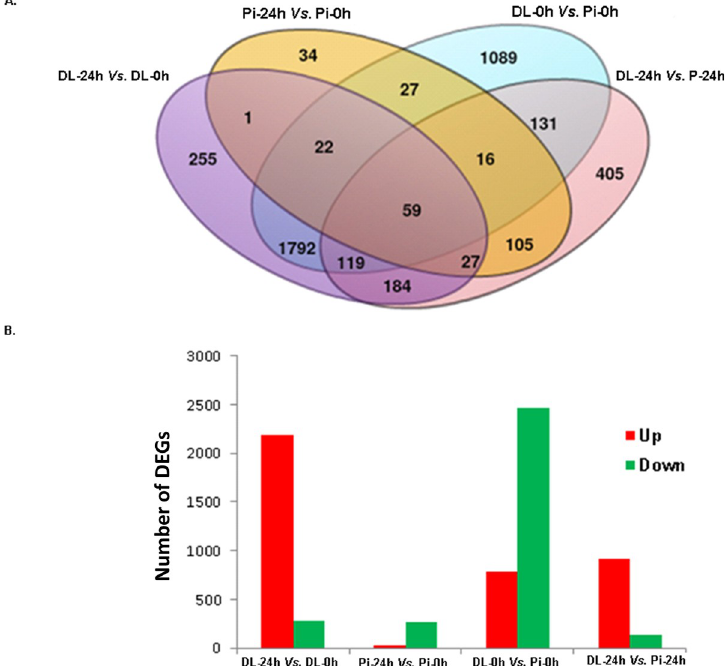
Fig 2. Number of DEGs after PRRSV vaccination. (A) The intersecting venn diagram demonstrates the number of DEGs identified at four contrast pairs such as PBMCs of DL pigs between pre and 24 h post vaccination (DL-24h vs. DL-0h); PBMCs of PI pigs between pre and 24 h post vaccination (Pi-24h vs. Pi-0h); unvaccinated PBMCs between DL and Pi pigs (DL-0h vs. Pi-0h), and vaccinated PBMCs between DL and Pi pigs (DL-24h vs. Pi-24h). (B) The bar graphs depict the proportion of DEGs showed their expression either up regulated (red bars) or down regulated (green bars) direction at four contrast pairs tested.